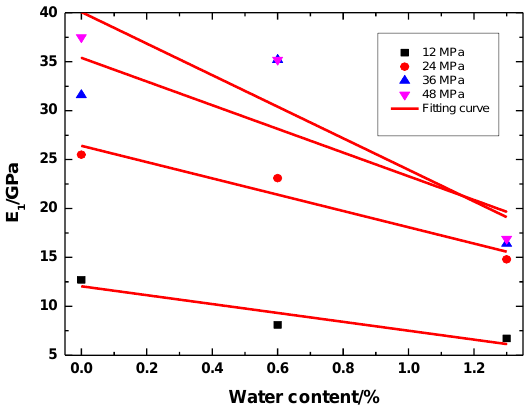
Figure 19. Elastic modulus with water content of 0° for slate.